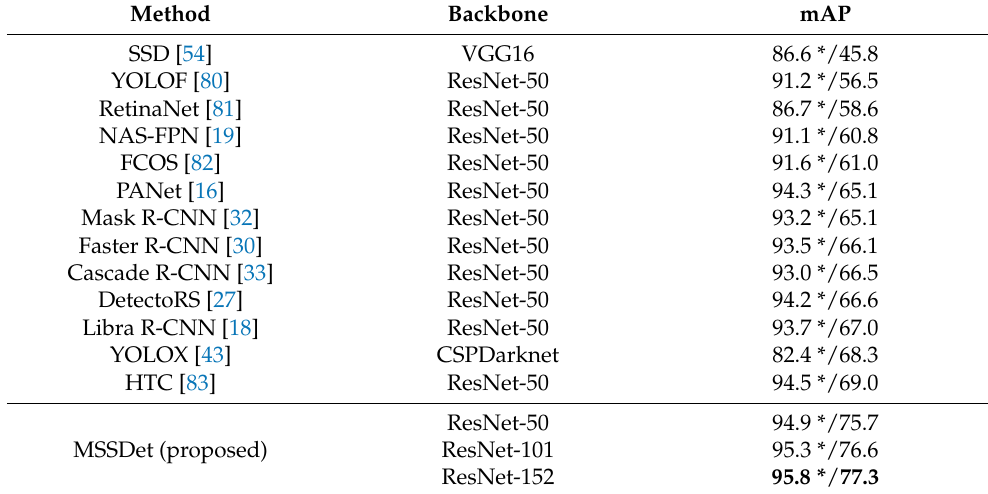
Table 3. Comparison with state-of-the-art methods on proposed HRSC2016-MS dataset and original HRSC2016 dataset. * denotes results on HRSC2016 dataset. Note that the semantic branch in HTC is removed, as semantic segmentation annotations are not available in these two datasets. The best result is highlighted in